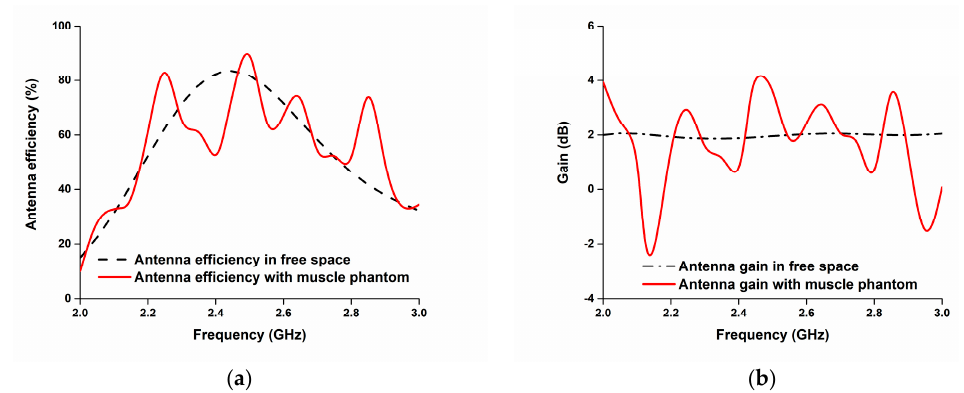
Figure 19. ( a ) Efficiency and ( b ) gain of the proposed antenna.